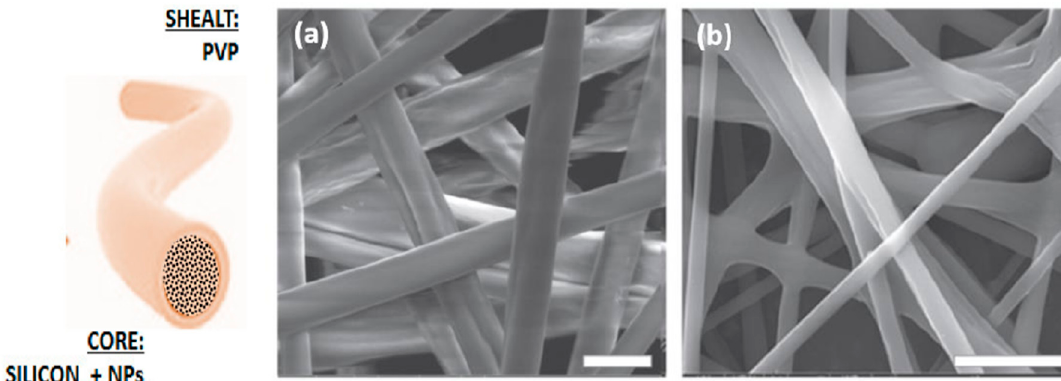
Figure 2. PDMS (Polydimethylsiloxane) / PVP core–shell fibers: SEM images of fibers ( a ) before and ( b ) after treatment in aqueous solution to remove the PVP shell (Scale bar 10 µ m). Reproduced by V. Guarino et al., 2018, Mater. Res. Express 5 085029 [16].